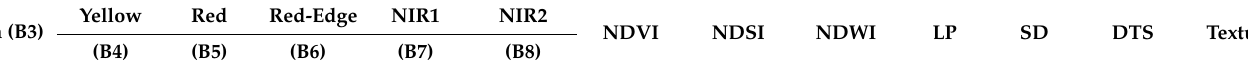
Table 1. Correlation matrix of predictor variables. Linear correlations (|r| ≥ 0.89) are shaded gray.